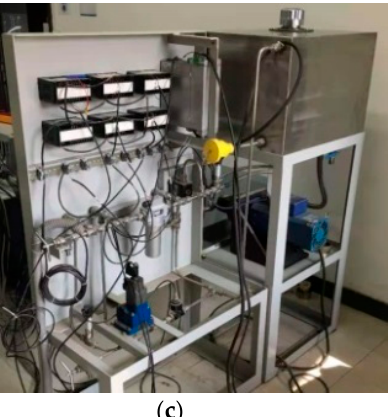
Figure 6. Experimental setup: ( a ) experimental pump; ( b ) schematic diagram; ( c ) experimental apparatus.